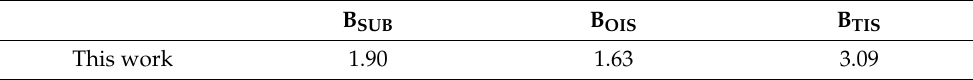
Table 1. The calculated formation energies (eV) of an isolated boron atom doped in copper. B SUB B OIS B TIS This work 1.90 1.63 3.09 In order to elucidate the kinetic behavior of boron in Cu-B composites, the diffusion and migration paths of boron in bulk copper are examined. Here, we only consider the barrier along the migration path through the relatively stable interstitial site by using the NEB method. According to the formation energies obtained above, the initial and final positions for the diffusion paths are both OISs in copper. The boron migration path 1 → 2 → 3 is also marked with the black arrows as shown in Figure 4. The results demonstrate that an interstitial boron atom has to overcome an energy barrier of 0.87 eV in order to diffuse between OISs.